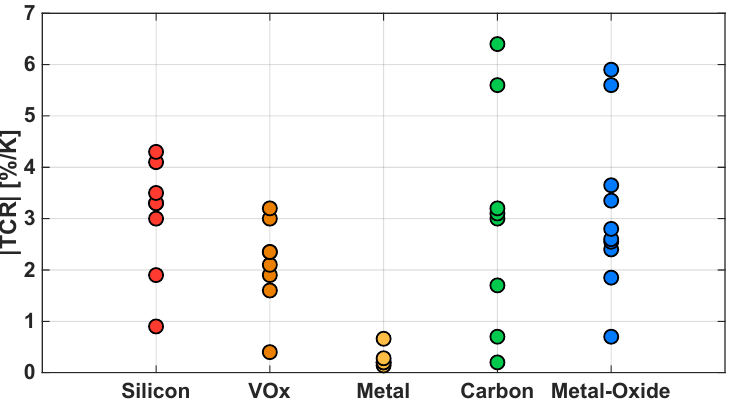
Figure 1. TCR values of commonly employed material types for the micro-bolometer’s sensing